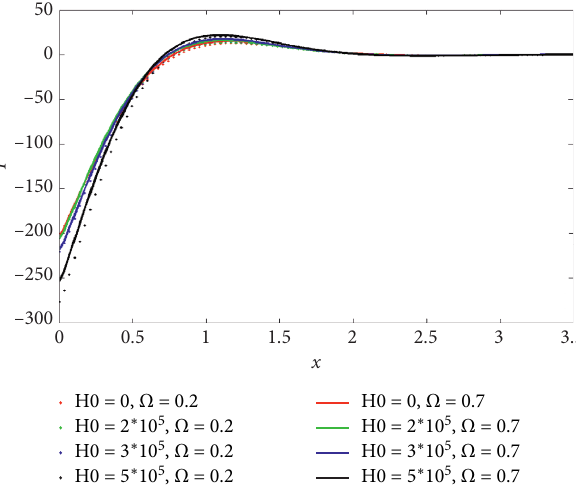
x with magnetic and rotation. xz concerning